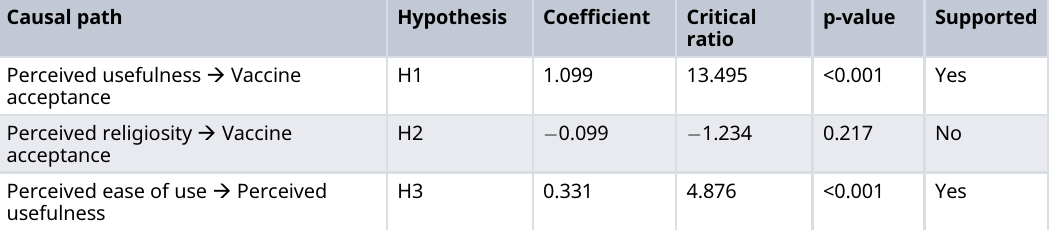
Table 4. Results of Structural Equation Model (SEM) analysis of modified